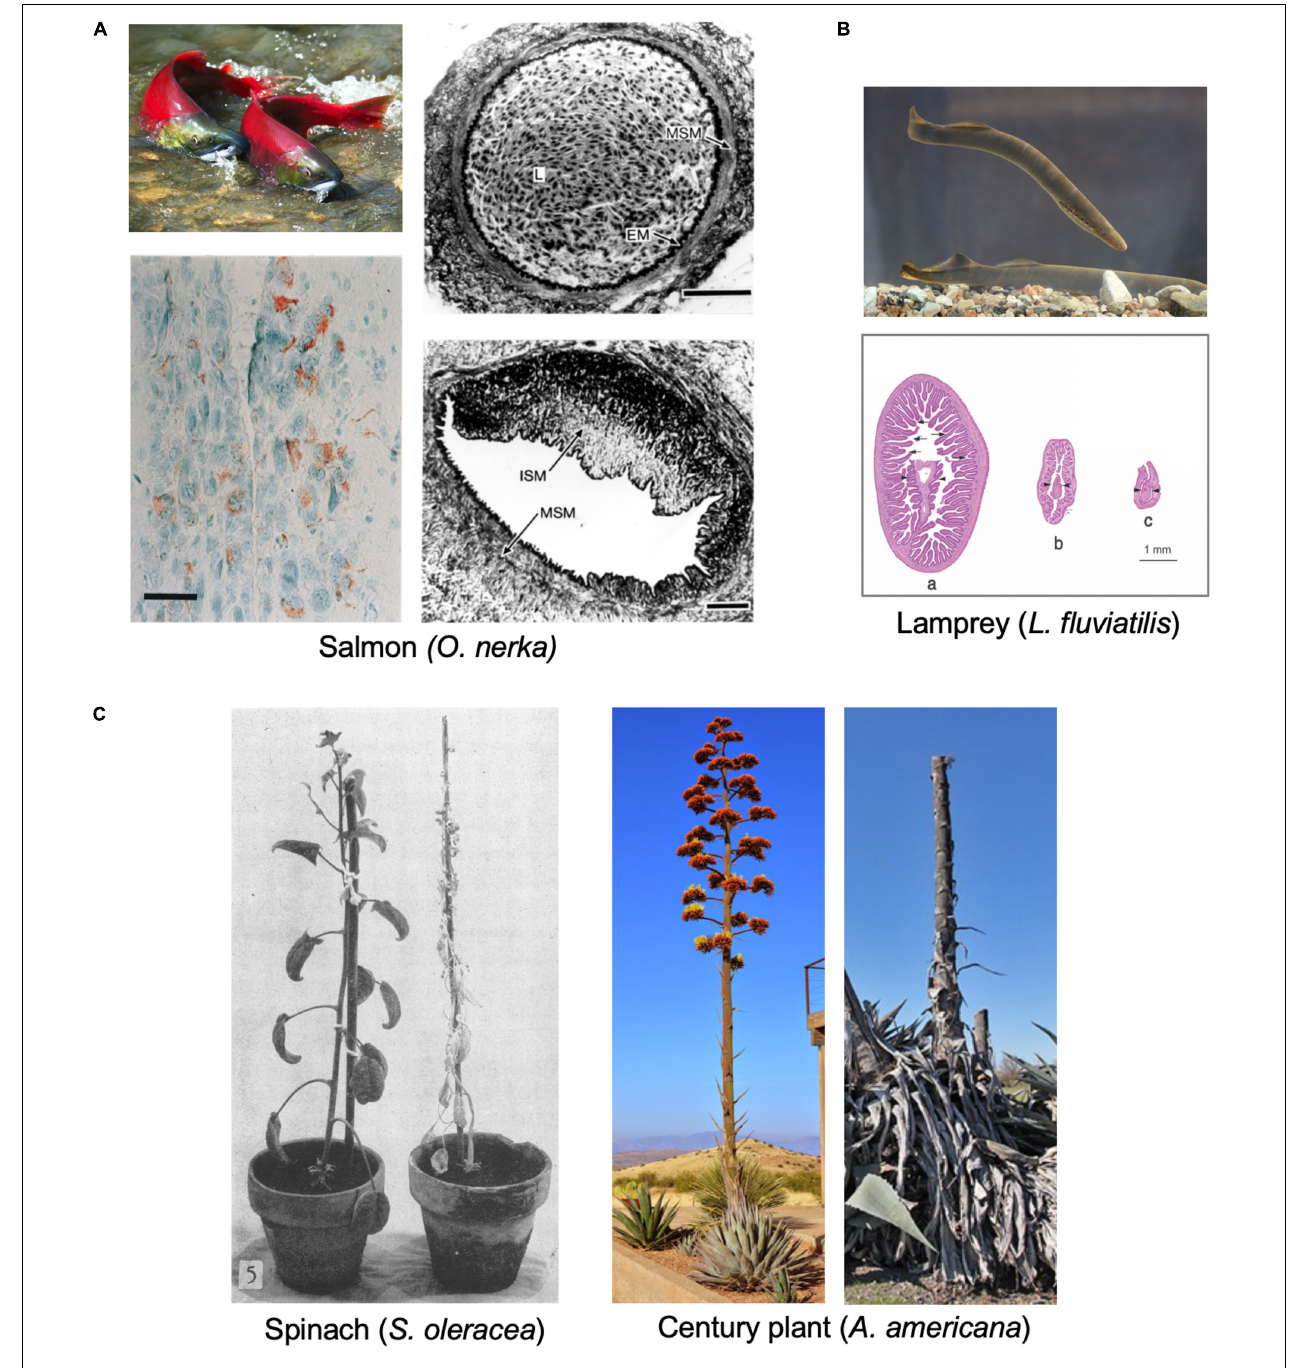
FIGURE 3 | Examples of semelparous organisms and their senescent pathologies. (A) Pacific salmon O. nerka . Top left: sexually mature adults (photo courtesy of Georgia Strait Alliance, www.georgiastrait.org© Olga Vasik—Adobe Stock). Bottom left: Immunoreactivity to A β 1 – 42 antibody in the brain of spawning kokanee salmon (Maldonado et al., 2000), c.f. amyloid plaques associated with Alzheimer’s disease. Bar, 20 µ m. Right: cross section of normal coronary artery (top); L, lumen, filled with nucleated red blood cells; MSM, medial layer of vascular smooth muscle; EM, elastic membrane; ISM; or (bottom) from mature adult with severe arteriosclerotic lesion, containing mainly intimal smooth muscle cells (ISM) (Farrell, 2002). Bars, 50 µ m. (B) Lamprey (genus Lampetra ). Top, European river lamprey ( L. fluviatilis ) (photo by Tiit Hunt, distributed under a CC BY-SA 3.0 license). Bottom: stages of intestinal atrophy during spawning in L. japonica . Diameters of (a) 3.9 mm, (b) 1.5 mm (b), and (c) 1 mm. Arrows, intestinal villi; arrowheads, typhosole (internal intestinal fold) (Higashi et al., 2005). (C) Examples of reproductive death in semelparous plants. Left, Spinacia oleracea 45 days after full bloom; reproductive death (right) has been suppressed by flower removal (left) (Leopold et al., 1959) (© American Society of Plant Biologists, reprinted with permission). Right, Agave americana during and after flowering (photos by Gerhard Bock, reproduced with permission). Century plants typically live 10–30 years, and death follows rapidly after a single massive reproductive event.